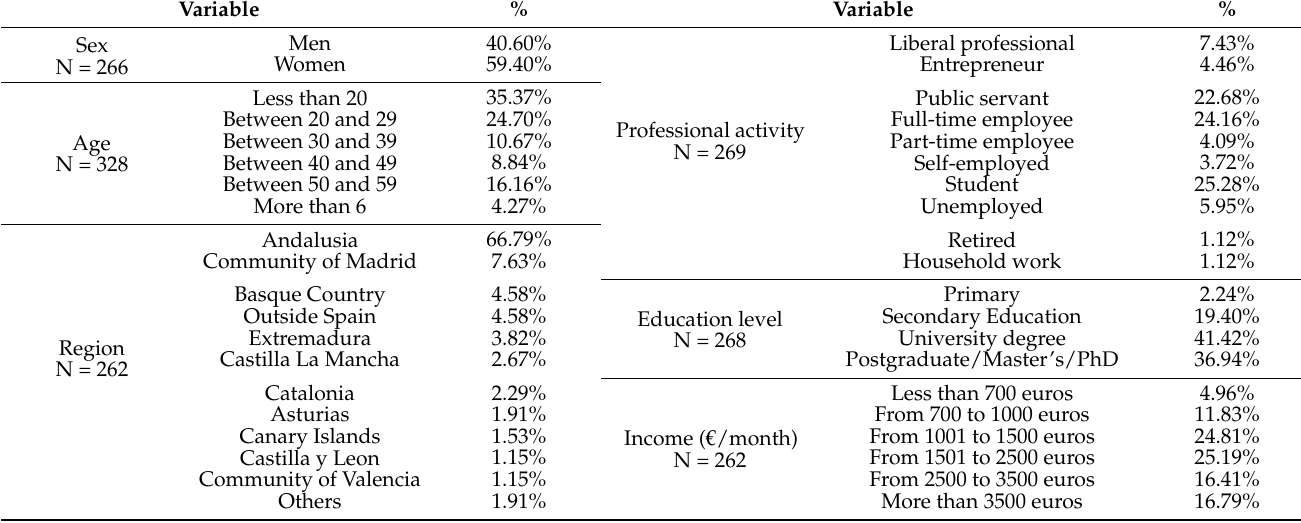
Table 1. Socio-demographic